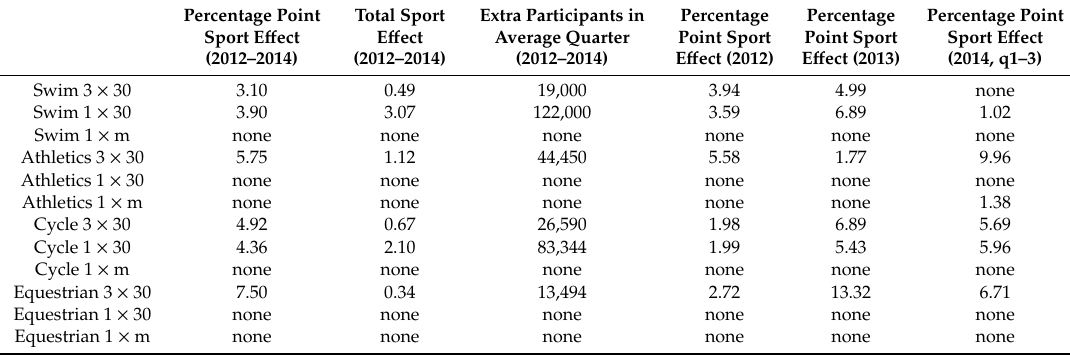
Table 3. Sport legacy e ff ect in some Olympic sports.